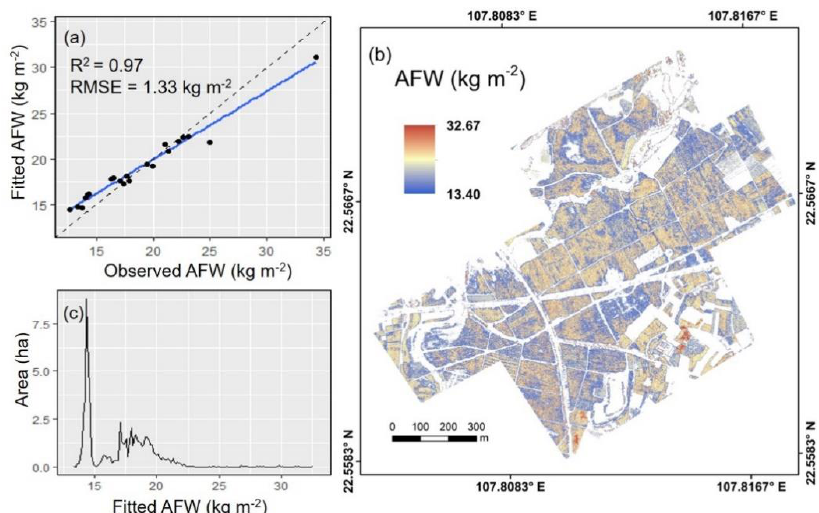
Figure 4. ( a ) Relationship between observed aboveground fresh weight (AFW) and fitted AFW of sugarcane via random forest regression (RFR) algorithms based on LiDAR point cloud data. ( b ) The predicted sugarcane AFW map of the study area derived from RFR algorithms at 1 m spatial resolution. ( c ) Frequency distribution curve of predicted AFW.